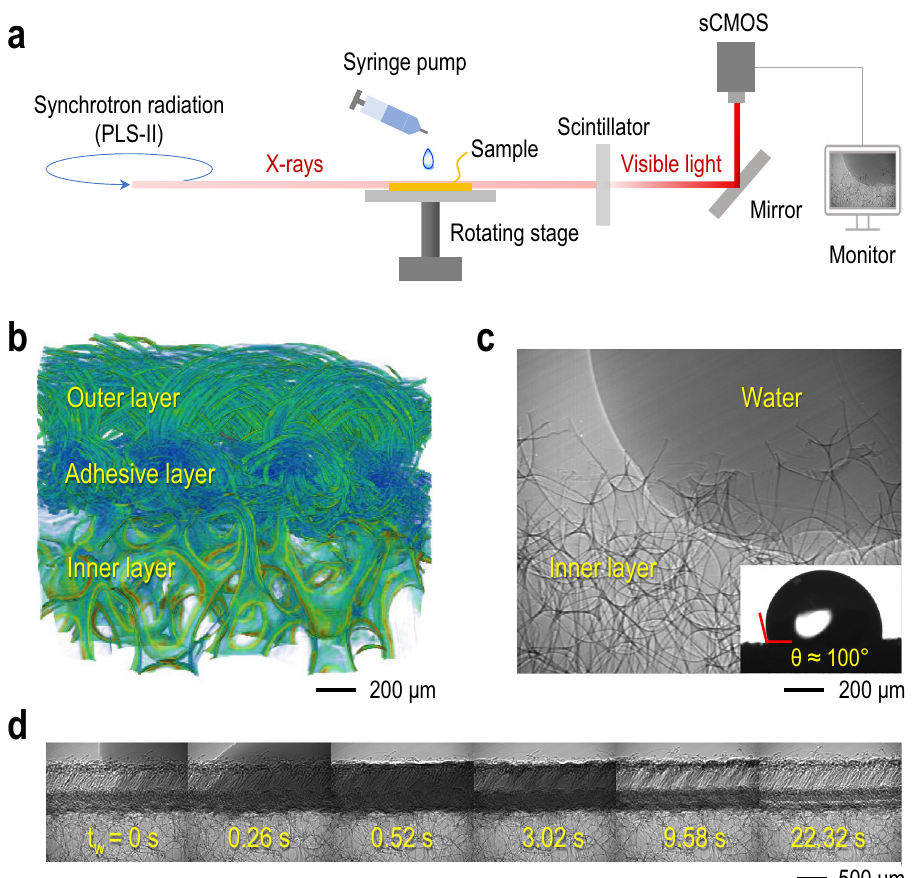
Figure 2. X-ray imaging for 2D microscopic and 3D microtomographic observations of a porous fabric and water dynamics. (a) Schematic illustration of the image acquisition process from X-ray microscopy technique (see details in “Methods”). (b) 3D reconstruction image of fabric with multiple (outer, adhesive, and inner) layers taken by X-ray microtomography (Generated with Amira software (version 2019.3)). (c) Little water imbibition to the inner layer taken by X-ray microscopy (Acquired with Micro-Manager software (version 1.4, https://micro-manager.org)). The inset side-view image represents the high intrinsic contact angle on the inner layer ( θ ≈ 100 ◦ ). (d) Real-time observation of water droplet (1 µ l) imbibition and evaporation taken by X-ray microscopy, showing that spreading and imbibition are confined in the outer layer (Movie S1). Here, t w corresponds to the beginning of wicking phenomenon (Acquired with Micro-Manager software (version 1.4,